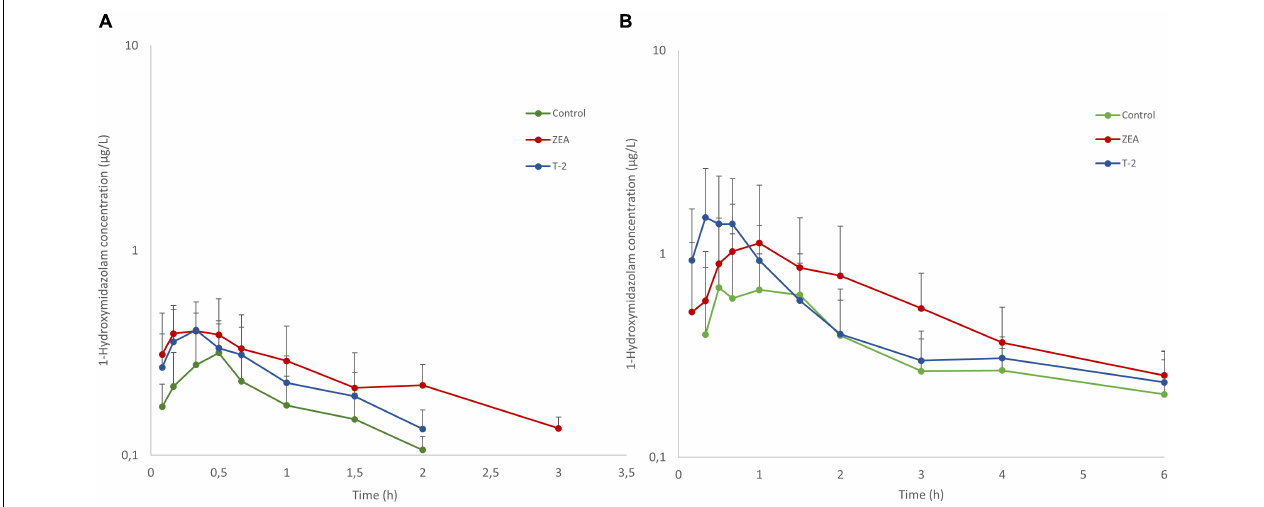
FIGURE 2 | Mean (+SD) plasma concentration-time profiles for 1-hydroxymidazolam after an intravenous dose of 0.036 mg/kg BW MDZ (A) and an oral dose 0.15 mg/kg BW of MDZ (B) . Control and T-2 group: n = 8, 4 boars and 4 sows, 9 weeks of age; ZEA group: n = 7, 4 boars and 3 sows, 9 weeks of age.